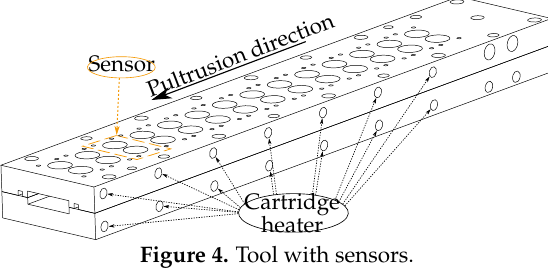
Figure 4. Tool with sensors.